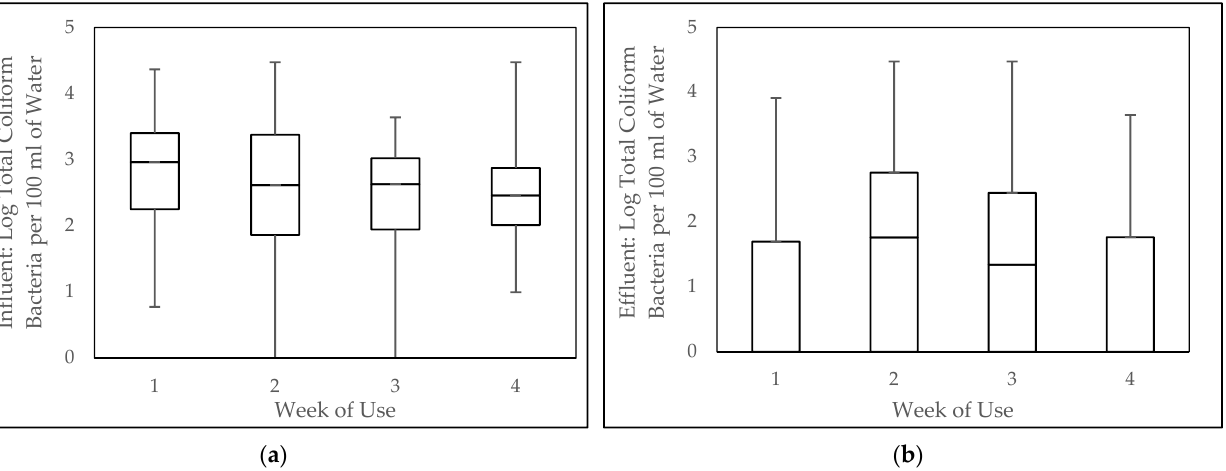
Figure 12. Mean values for silver concentration in effluent water from the intervention. Error bars indicate the standard error above and below the mean.